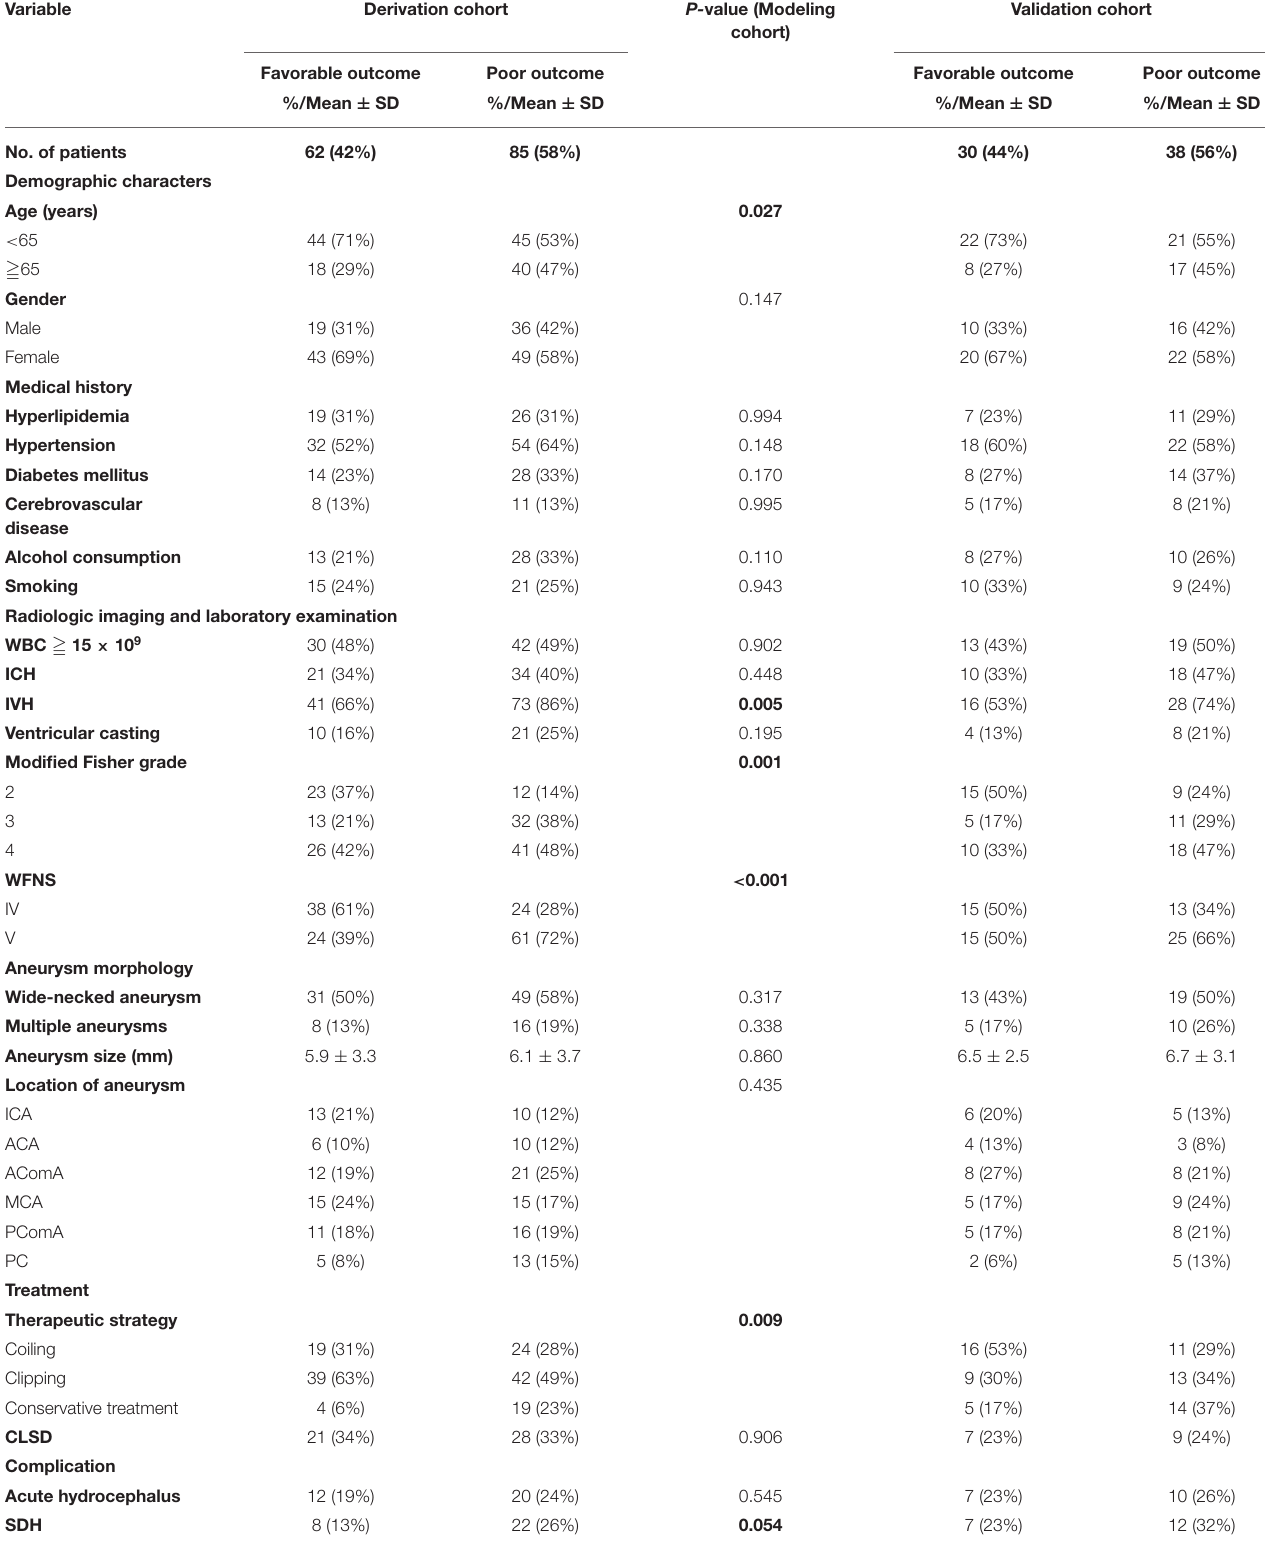
TABLE 1 | Demographic and baseline characteristics of the study population and univariate analysis results of modeling cohorts.